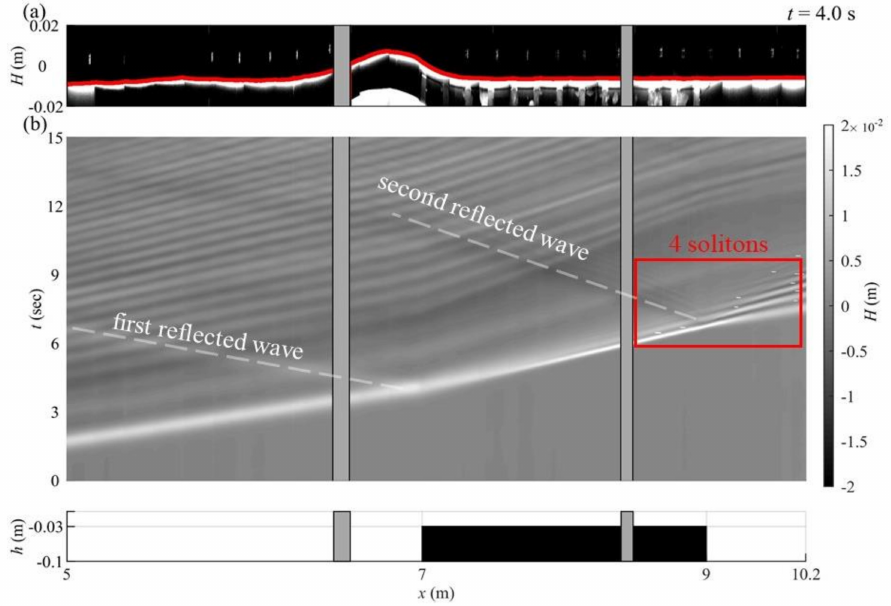
Figure 2. ( a ) Snapshot of the free surface and ( b ) 2D spatial-temporal results of the waveforms of experimental results of Case 06 after